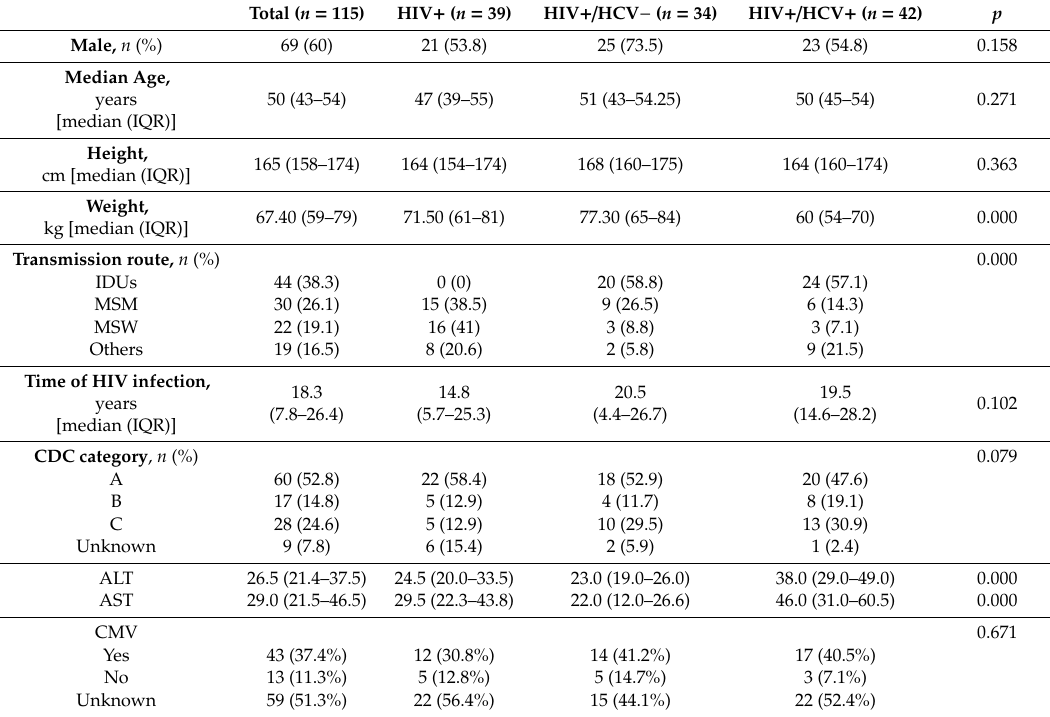
Table 1. Socio-demographic characteristics and HIV therapy of study